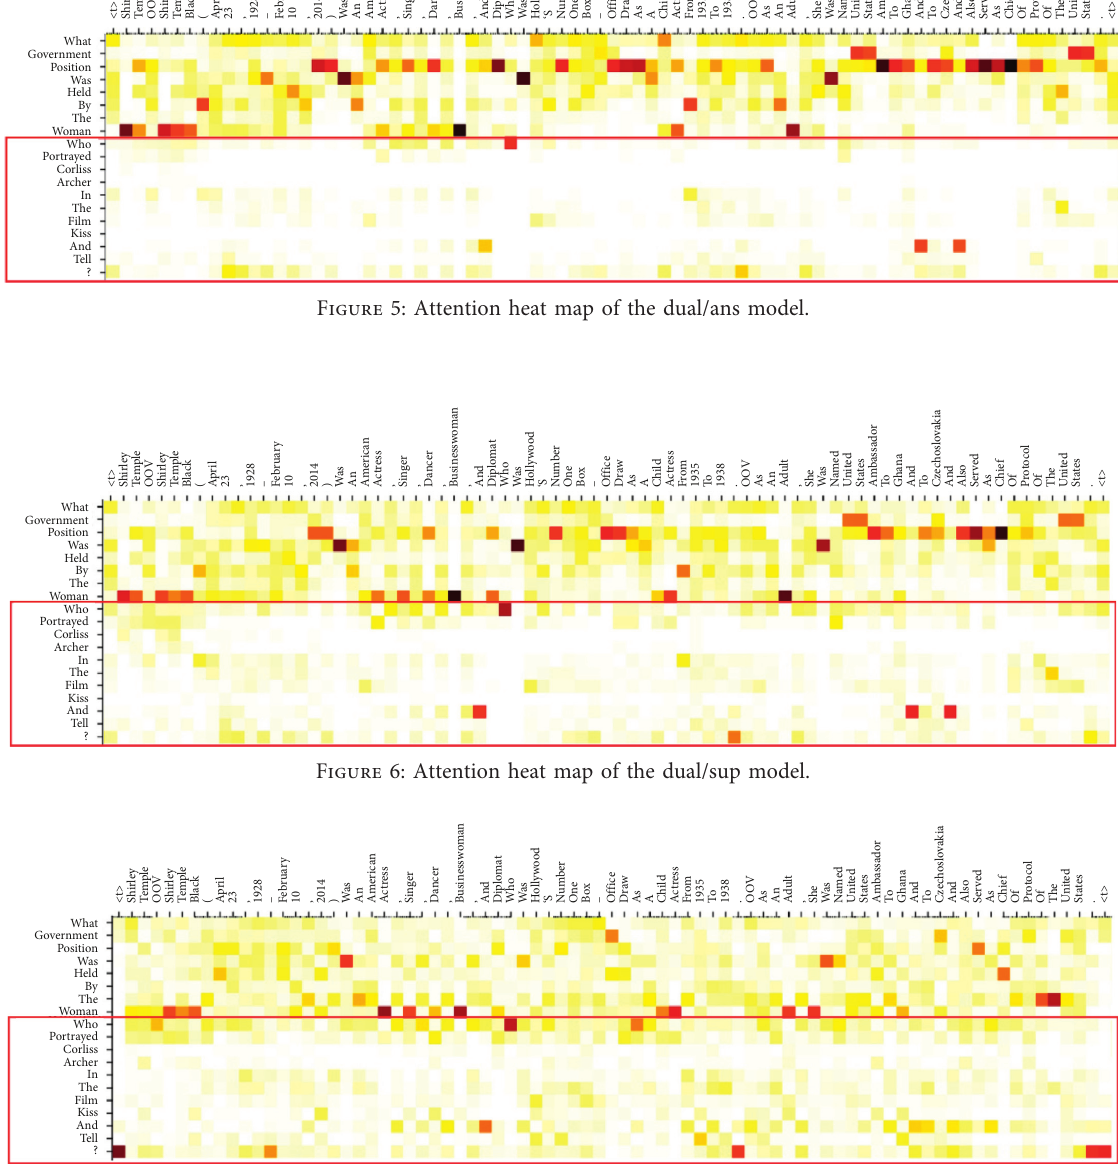
Figure 7: Attention heat map of the only-sup model.